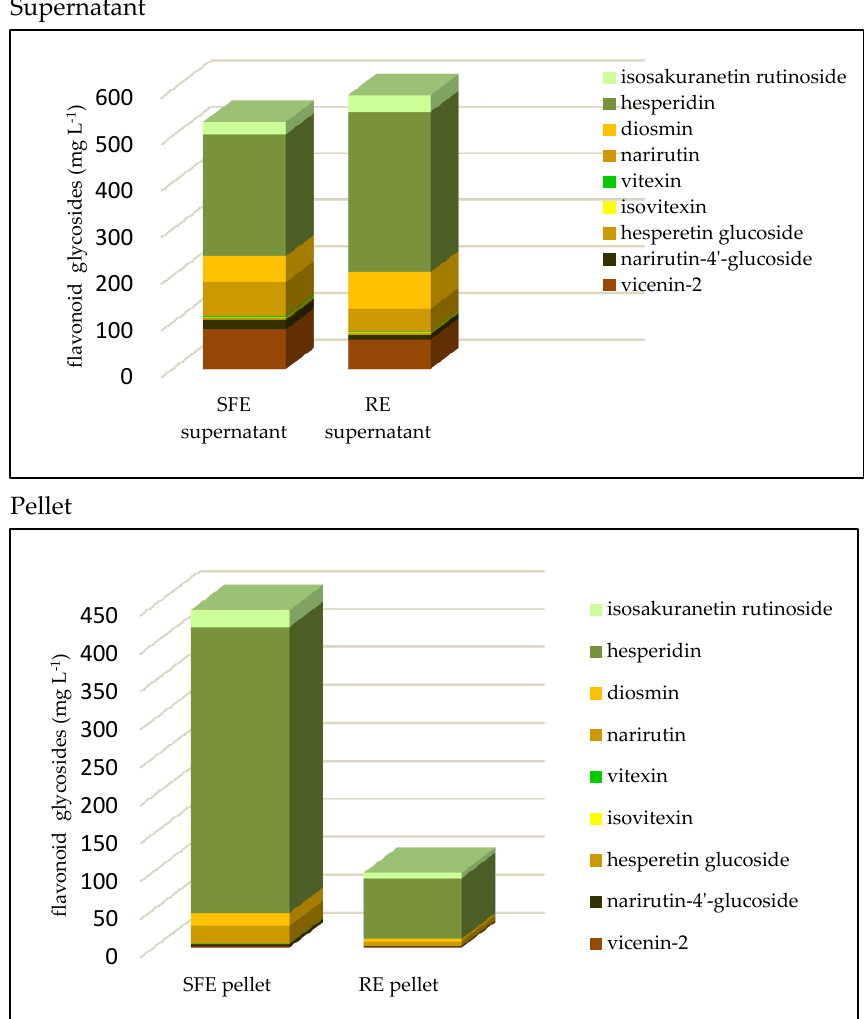
Figure 2. Flavonoid glycoside content in “Valencia” orange juice processed with shear force extractor (SFE) and reamer extractor (RE) types.